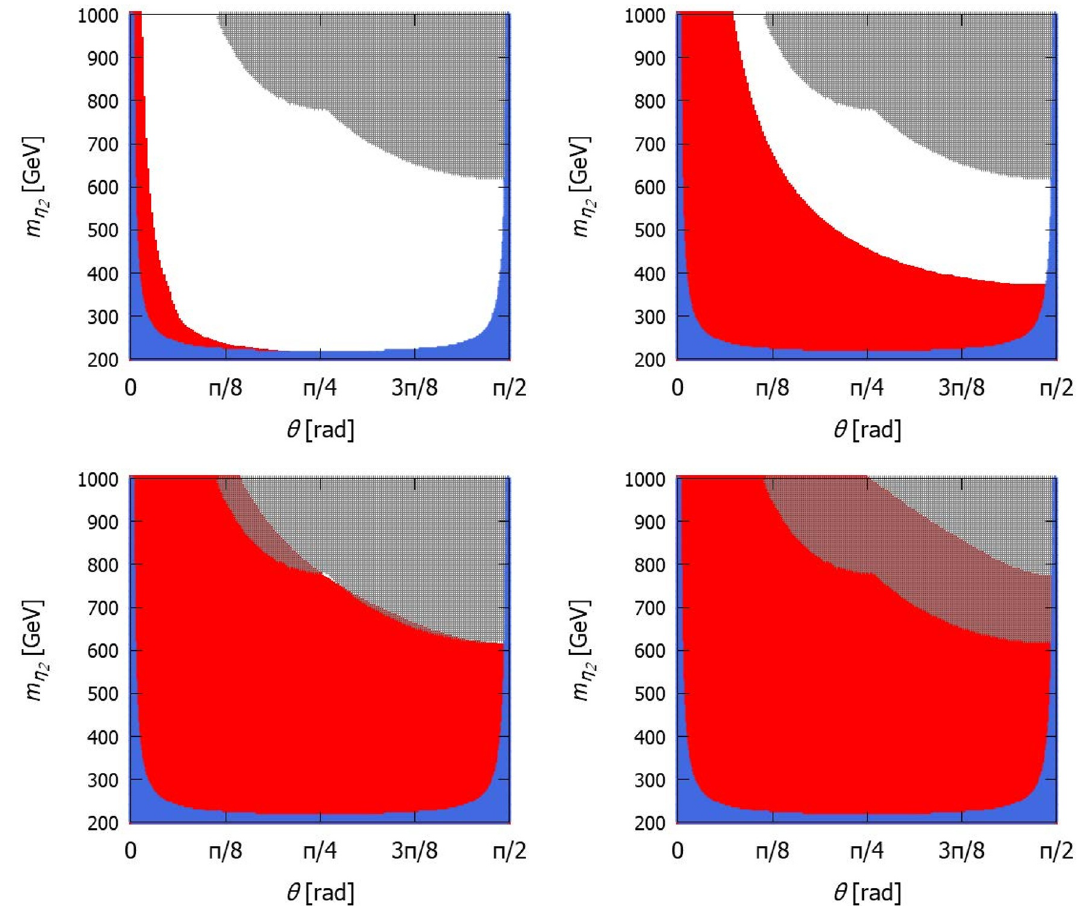
Figure 4 . Excluded regions in the θ – m plane for m η = 63 GeV, m = 200 GeV and λ DM = 10 − 3 . η ± 2 η ± 1 R The efficiency factor (cid:15) is taken to be 0.3% (value obtained by naive estimation: upper-left), 3% (upper-right), 30% (lower-left) and 100% (lower-right). The value of m η is fixed so as to ensure I ∆ T = 0 . The other input parameters λ 2 , 6 , 7 , 8 are taken to be zero in this plot. The regions shaded in gray, red and blue are excluded by the perturbative unitarity bound, the LHC data and the perturbativity bound ( f µ f µ ≤ 4 π ) for M µ = 2 TeV, L R